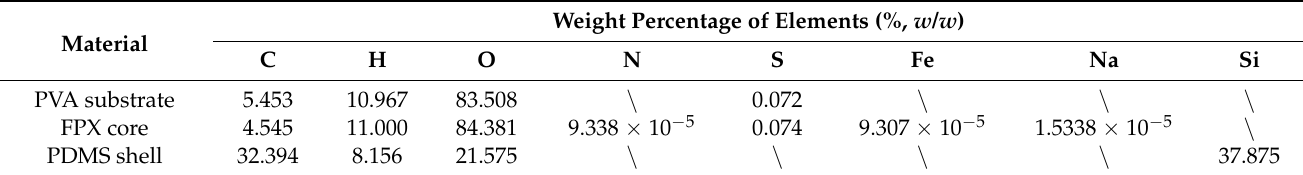
Table 1. Weight percentage of elements in different